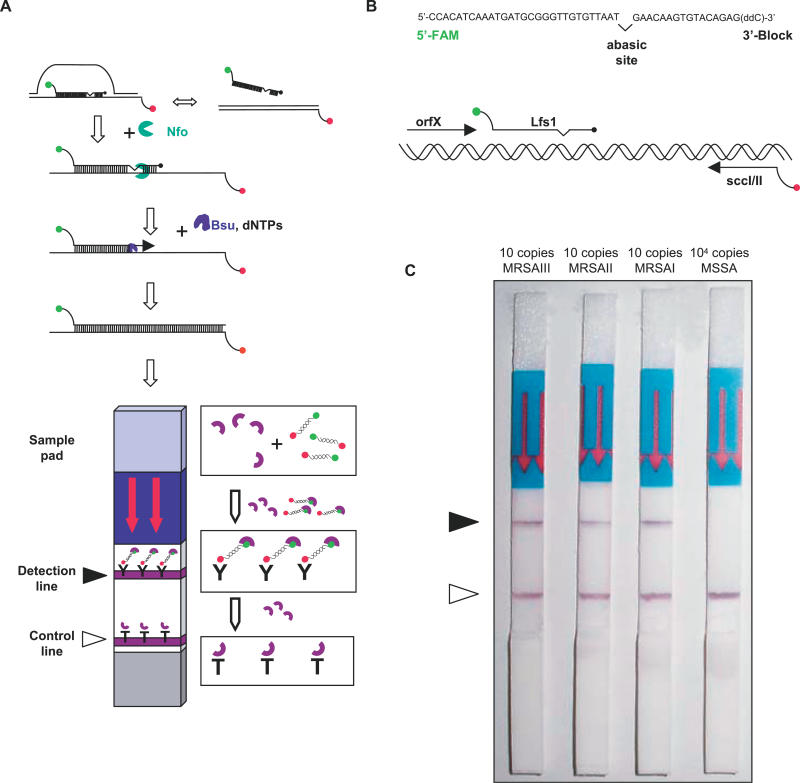
RPA for MRSA Detection Can Be Combined with an Instrumentation-Free Read-out System(A) Schematic of the principle of product generation and lateral-flow strip detection (see text for details). FAM label (green), biotin label (red), α-FAM-gold (purple), α-biotin antibody (Y, detection line, filled arrowhead), species-specific α-[α-FAM-gold] antibody (T, control line, open arrowhead).(B) Schematic of the lateral-flow probe design (top, here Lfs1) and its arrangement relative to amplification primers (bottom, here orfX and sccI/II). FAM label (green), biotin label (red).(C) Lateral-flow strips used for the detection of RPA products. Reactions contained (left to right) ten copies of MRSAIII, ten copies of MRSAII, ten copies of MRSAI, or 10,000 copies of MSSA (negative control) as template. Positive signals are generated in the first three reactions (filled arrowhead). The MSSA control reaction only produced a flow-control signal.